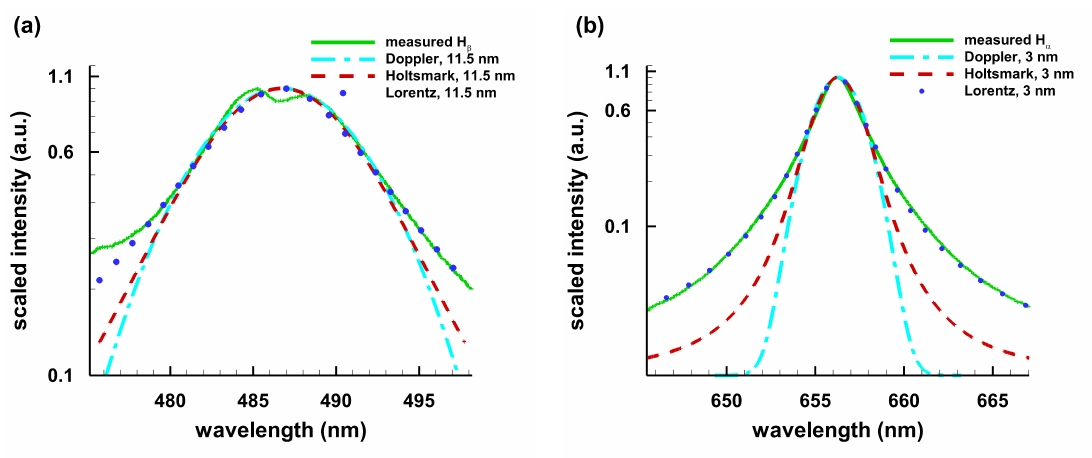
Figure A3. Comparison of measured data at a time delay of 175 ns, one-dimensional Holtsmark, Lorentz, and Doppler line shapes with the same full-width-half-maxima: ( a ) H β ; and ( b ) H α .